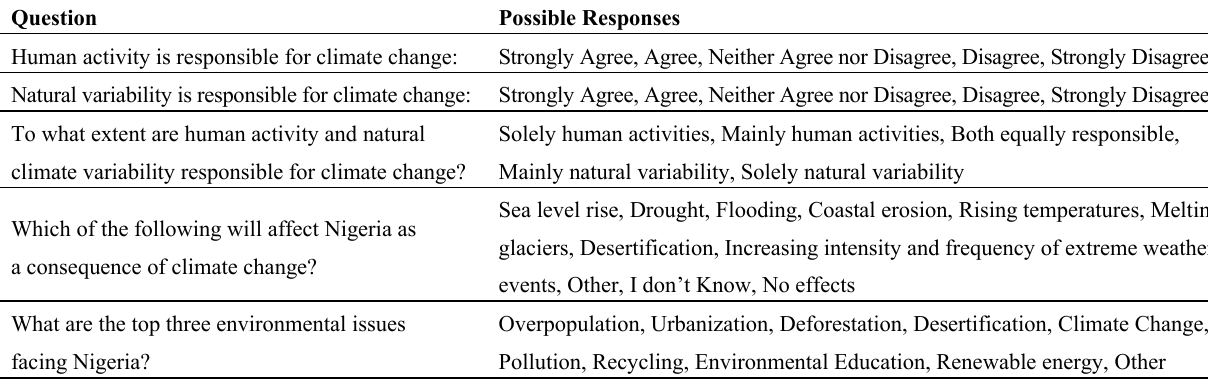
Table 1. Questions posed to study participants and analyzed in this